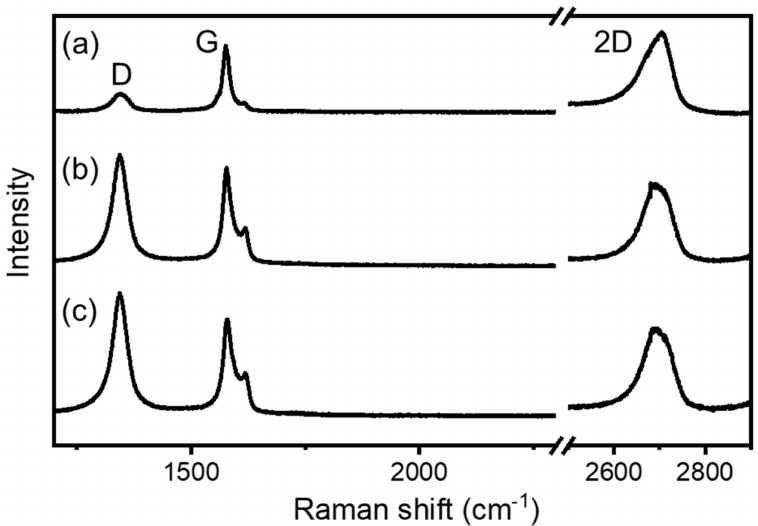
Figure 2. Raman spectra of ( a ) graphite and graphene dispersed by ( b ) octylbenzene and ( c ) 1,4-dioctylbenzene.